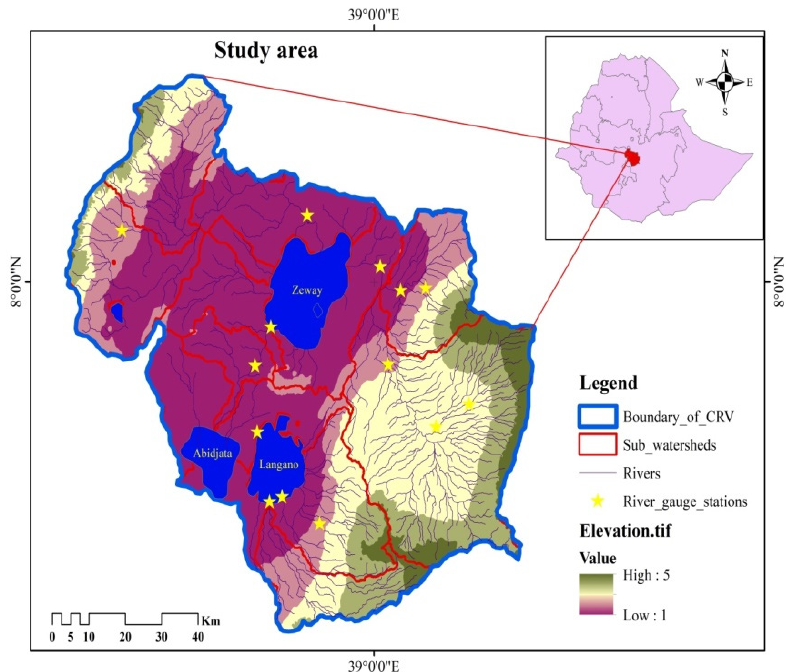
Figure 1. Map of the study area of the Central Rift Valley in